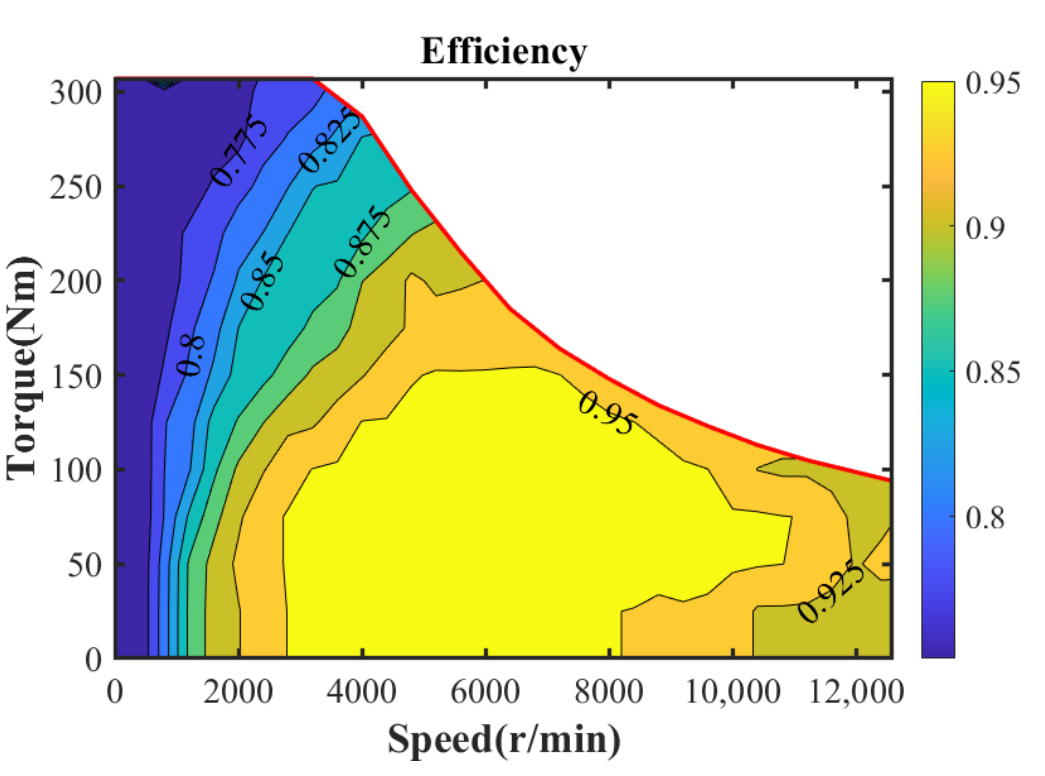
Figure 2. Motor efficiency contour